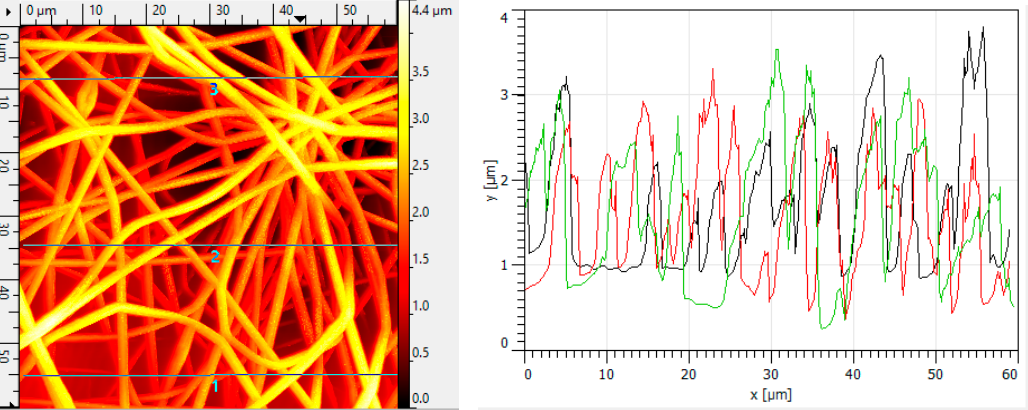
Figure 11. On the left: 2D AFM image of the PVC-ZnO sample. Image dimensions: 60 × 60 µm. On the right: roughness profiles corresponding to the tree evaluation lines indicated on the left. Reprinted with permission of [72].